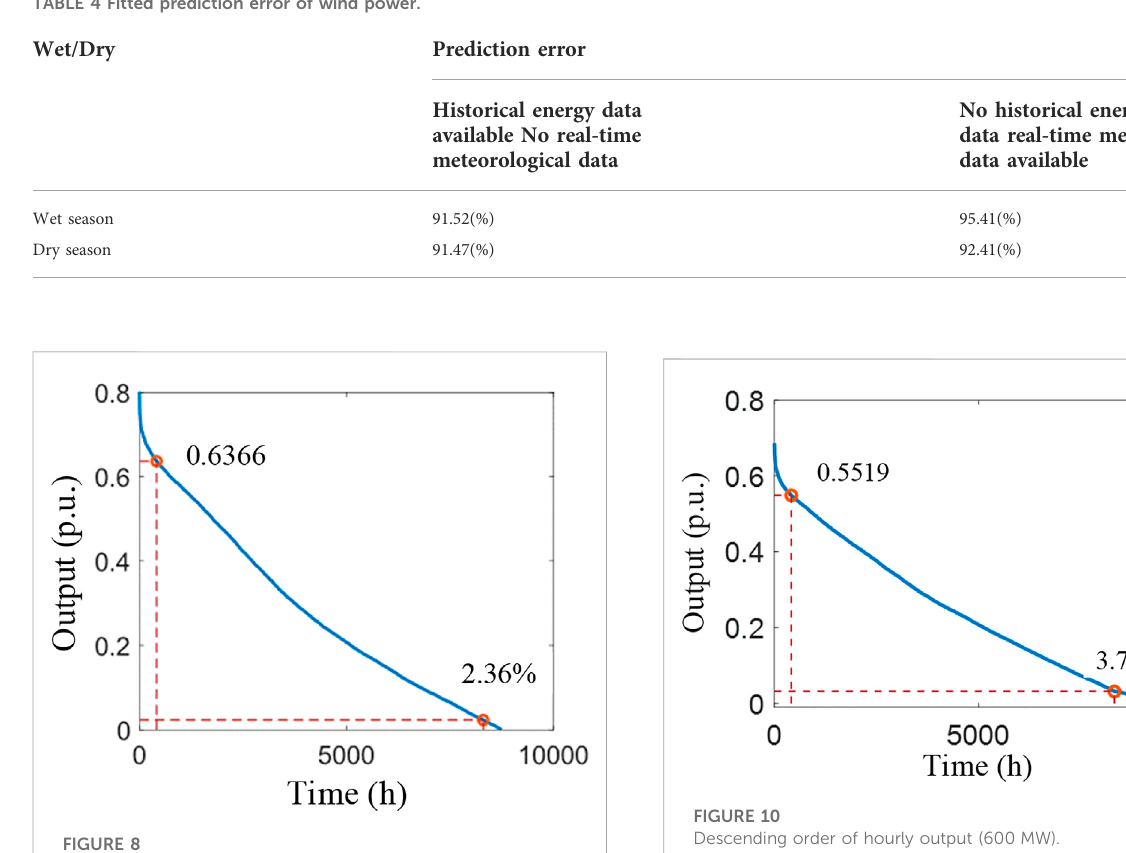
FIGURE 10 Descending order of hourly output (600 MW).